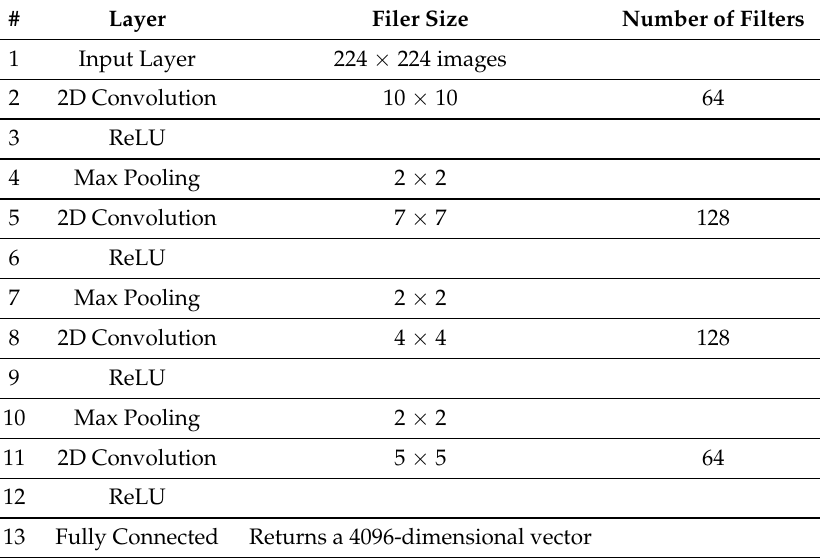
Table 1. Siamese subnetworks